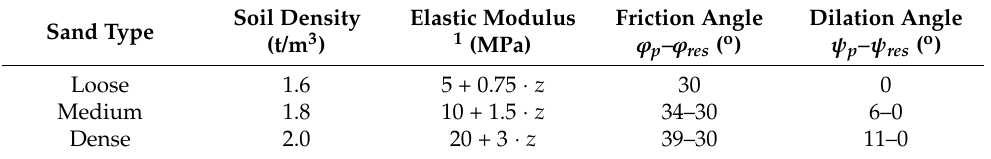
Table 1. Soil layer